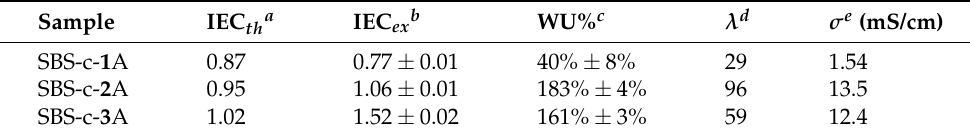
Table 2. Properties of the AEMs obtained in this study.